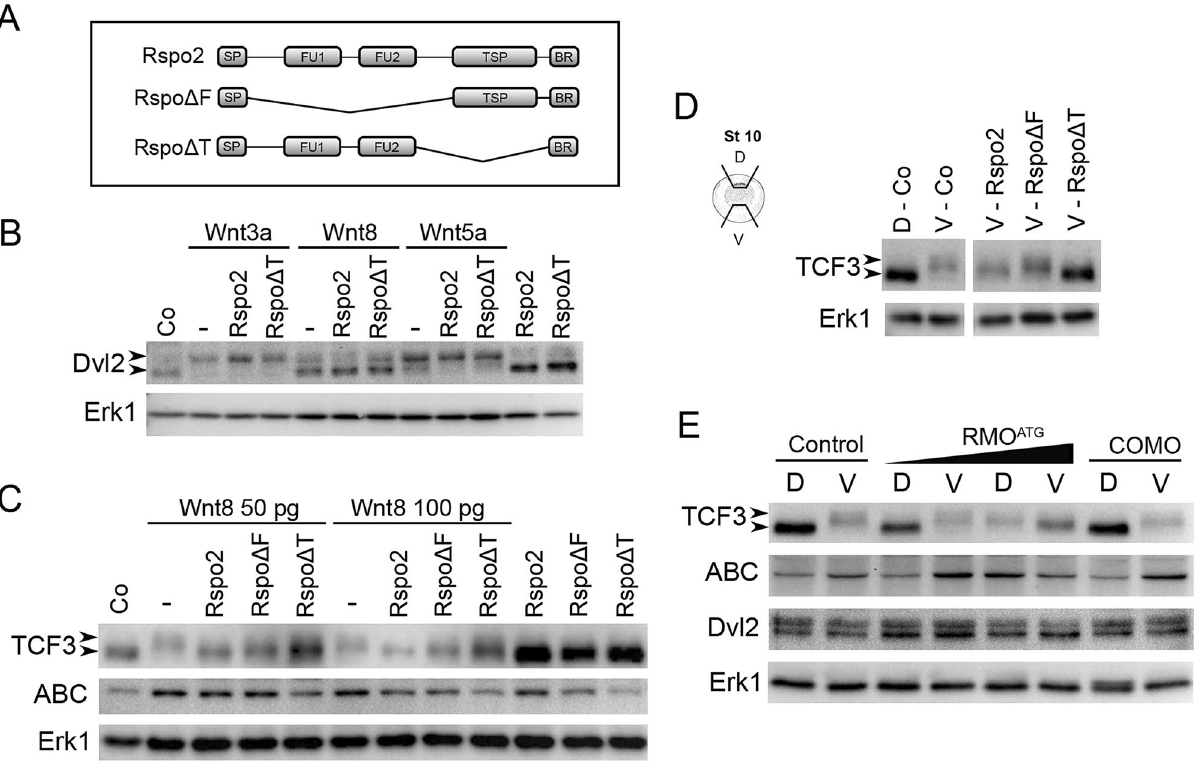
Figure 4. Rspo2 inhibits TCF3 phosphorylation. ( A ) Schematic of Rspo2 deletion constructs. SP, signal peptide; FU1, furin-like domain 1; FU2, furin-like domain 2; TSP, thrombospondin type 1 domain; BR, the basic amino acid-rich domain. ( B , C ) Effects of Rspo2 constructs on Wnt-dependent Dvl2 phosphorylation ( B ) and TCF3 phosphorylation and β-catenin levels ( C ). Four-cell stage embryos were injected animally with Wnt8 DNA (50 pg or 100 pg) or Wnt8, Wnt3a or Wnt5a RNAs (1 ng each) and Rspo2, Rspo∆F or Rspo∆T RNAs (0.5 ng each) as indicated. Ectoderm explants were dissected at stage 9 and cultured until stage 12 for immunoblotting with antibodies against Dvl2, TCF3, ABC (non-phosphorylated β-catenin). Arrowheads indicate the position of phosphorylated (upshifted) and non-phosphorylated Dvl2 or TCF3 proteins. Erk1 controls for loading. ( D ) Effects of Rspo2 constructs (0.5 ng each) on TCF3 phosphorylated by endogenous signals. Dorsal marginal zone (D) and ventral marginal zone (V) were dissected from the control and injected embryos at stage 10 and cultured until stage 12.5 for immunoblotting with anti-TCF3 antibodies as shown. Control D and V groups were run in the same gel but separately from the other groups (see Supplementary Fig. 5). ( E ) Effects of Rspo2 depletion on TCF3 phosphorylation by endogenous signals. DMZ and VMZ explants of embryos injected with control MO (COMO, 20 ng) or RMO ATG (20 ng) were dissected and analyzed by immunoblotting as in ( B , C